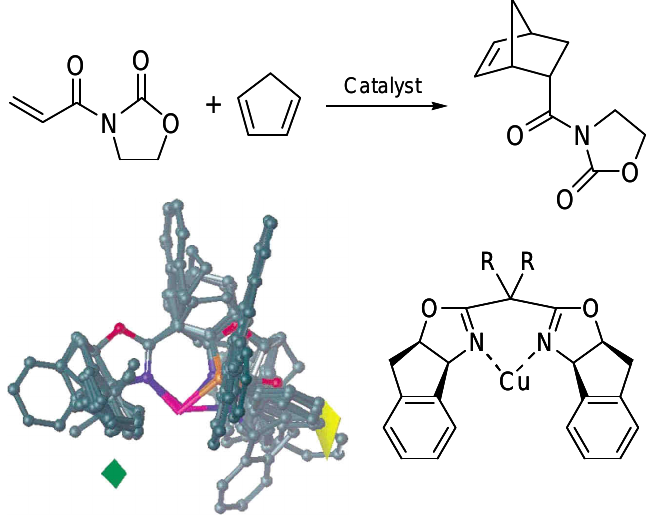
Figure 4 . (top) Scheme of the Diels-Alder reaction between N-2-alkenoyl-1,3-oxazolidine-2-one with cyclopendadiene.; (bottom) Alignment of all 23 bisoxazoline and phosphinooxazoline ligands used in the CoMFA study. Regions of space where steric bulk should enhance or decrease stereoinduction are plotted using iso-value contour maps. Placement of bulky groups near the green region and/or removal of steric bulk near the yellow region should increases the ee for those catalysts that are not very